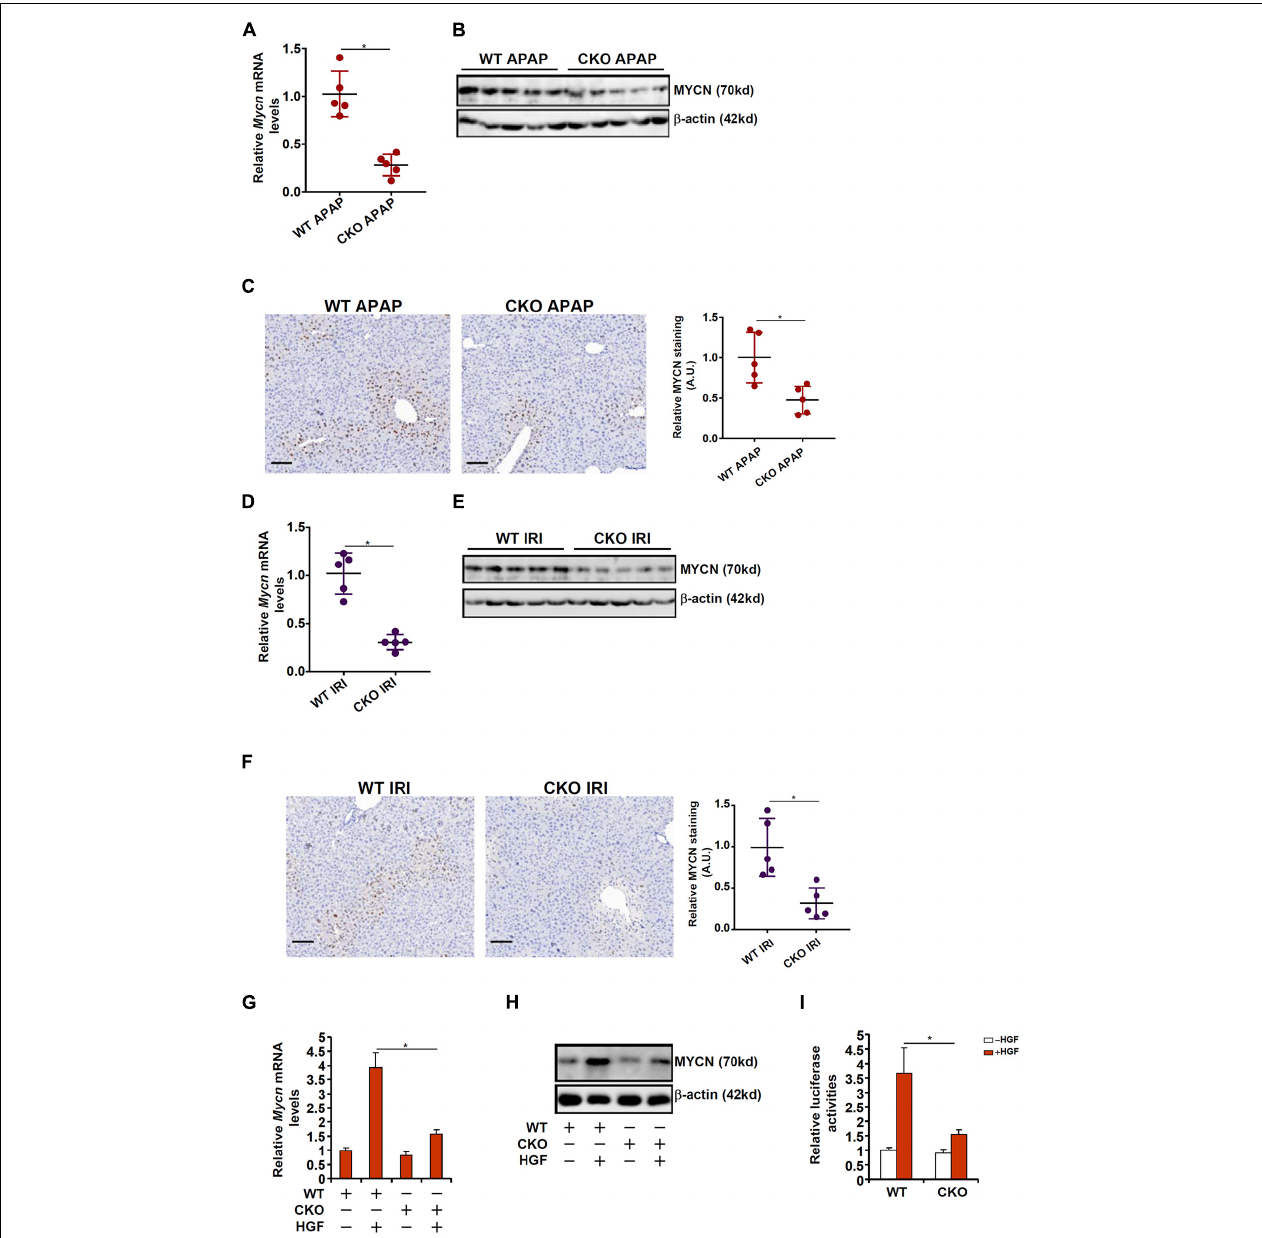
FIGURE 3 | MYCN down-regulation as a result of hepatocyte conditional BRG1 deletion. (A–C) WT and BRG1 CKO mice were injected with APAP (300 mg/kg) and sacrificed 24 h after the injection. MYCN expression was examined by qPCR, Western blotting, and immunohistochemical staining. (D–F) WT and BRG1 CKO mice were subjected to ischemia-reperfusion and sacrificed 24 h after the injection. MYCN expression was examined by qPCR, Western blotting, and immunohistochemical staining. (G,H) Primary murine hepatocytes were isolated from WT and BRG1 CKO mice and treated with or without HGF for 24 h. MYCN expression was examined by qPCR and Western. (I) A MYCN promoter-luciferase construct was transfected into primary murine hepatocytes isolated from WT and BRG1 CKO mice followed by treatment with HGF. The cells were harvested at indicated time points and luciferase activities were normalized by GFP fluorescence and protein concentration. Data are expressed as mean ± standard deviation (SD). * p < 0.05 (one-way ANOVA with post hoc Scheffe